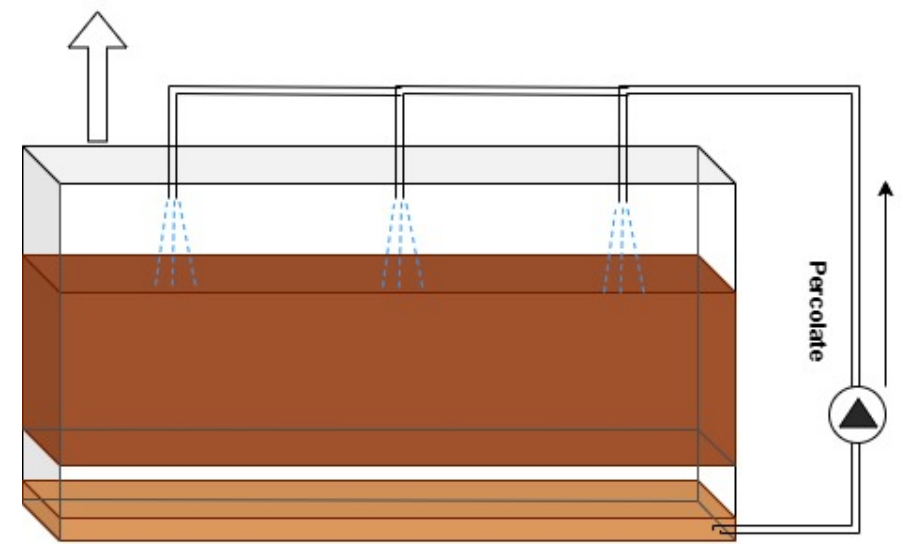
Figure 9. The reactor that provides the Biocel process.